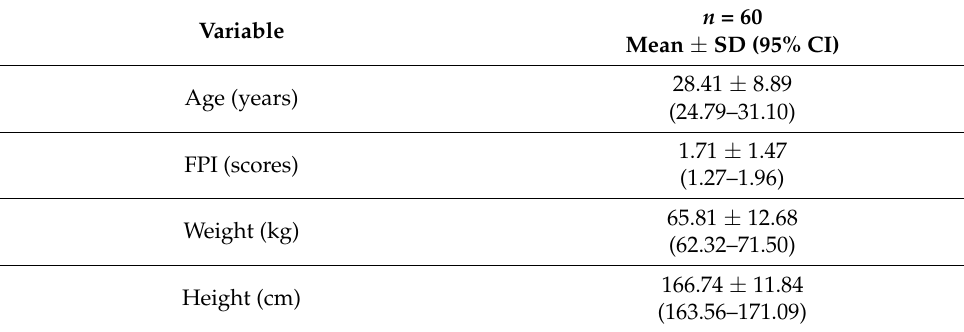
Table 2. Characteristics of subject